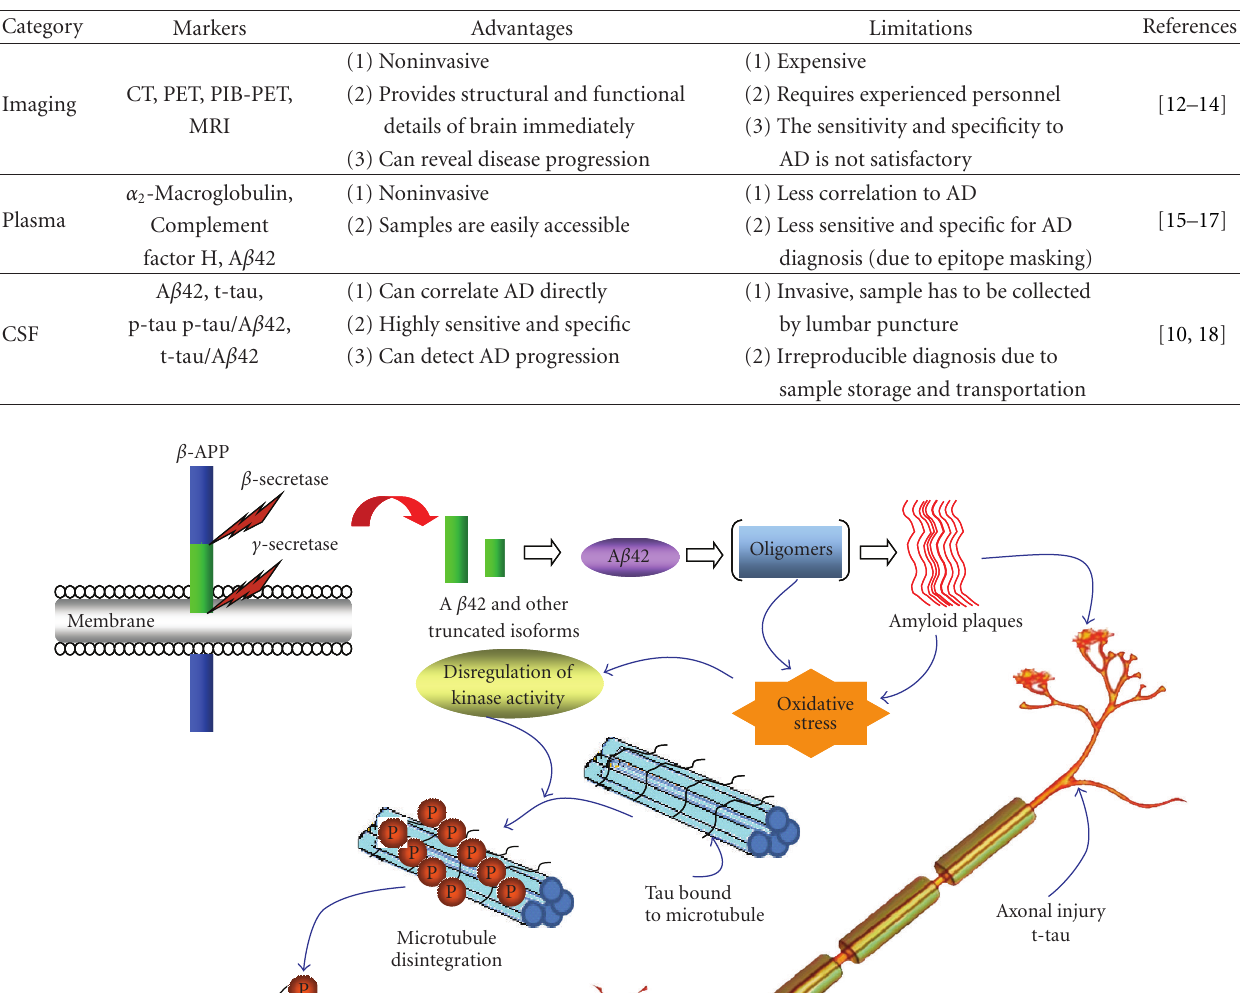
Table 1: Some promising biomarkers in diagnosis of AD.